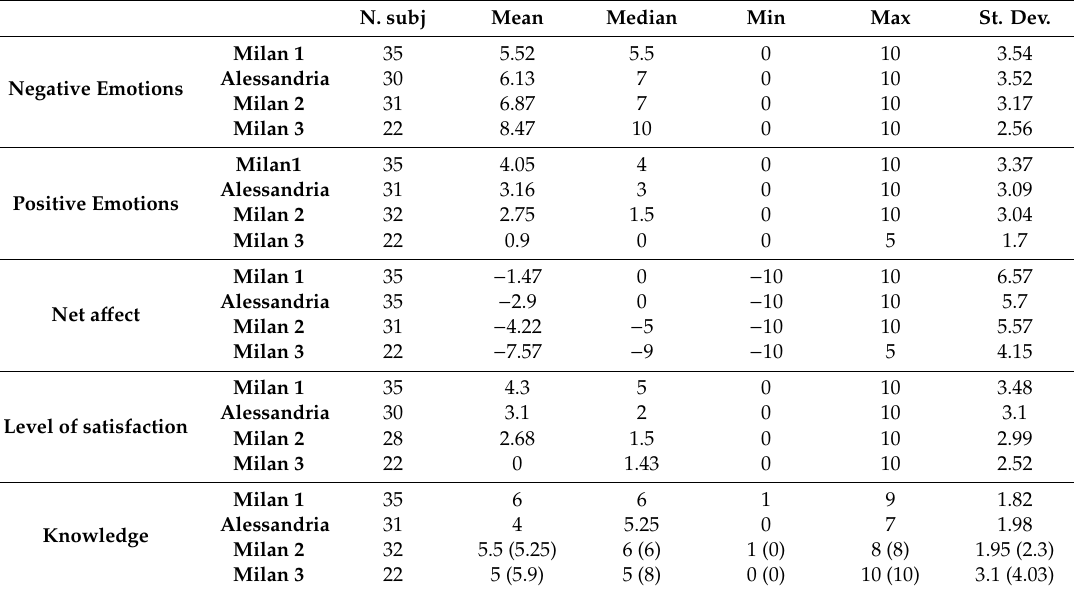
Table A6. Descriptive statistics for emotions and